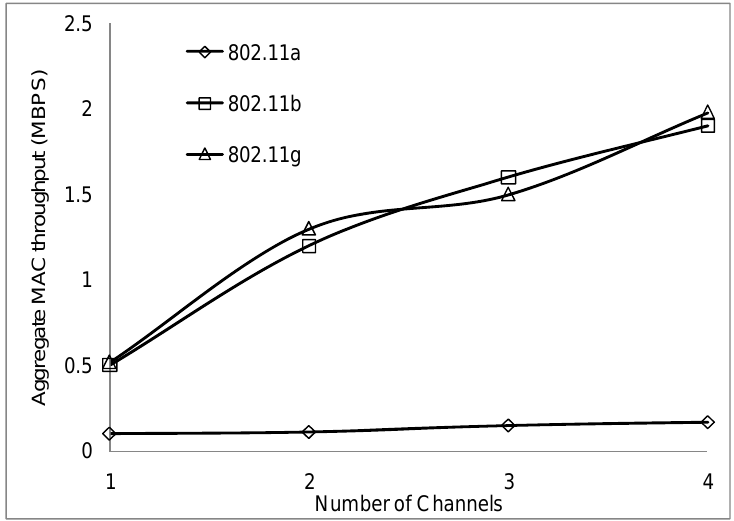
Figure 24. Aggregate throughput at 50 m range and data rate of 2 Mbps.